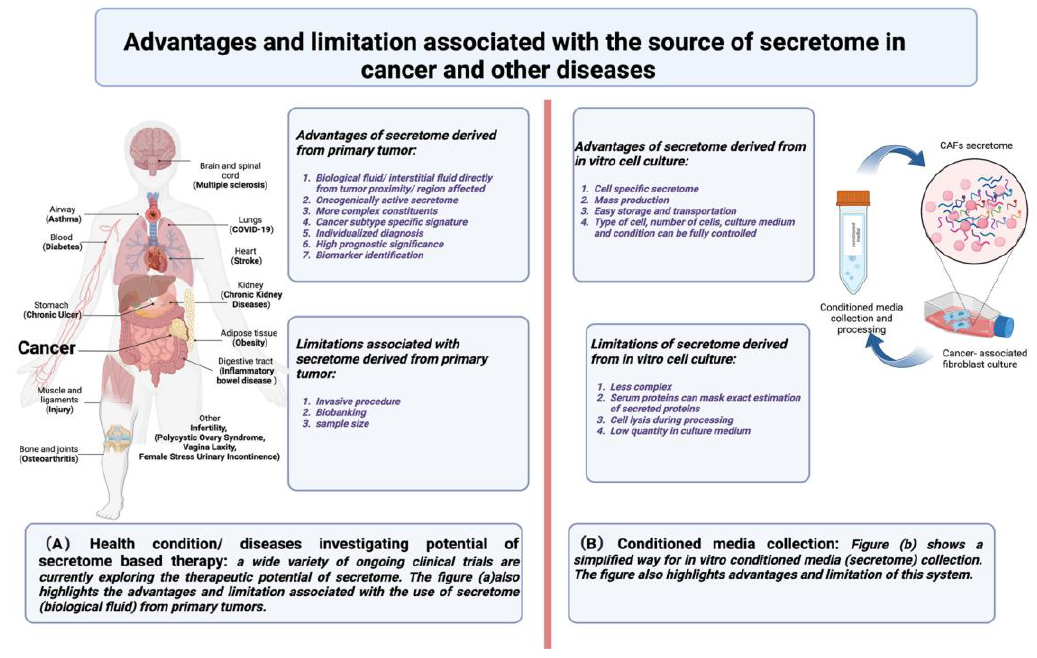
Figure 1. Secretome: Advantages and limitations; ( A ) shows different diseases exploring the clinical relevance of secretome-based therapy; ( B ) addresses the advantages and limitation associated with the use of CAFs (cell specific) secretomes in cancer.